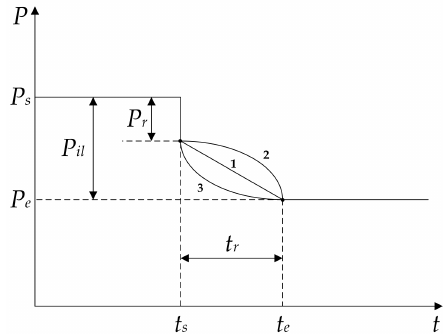
Figure 1. Response characteristic of interruptible load